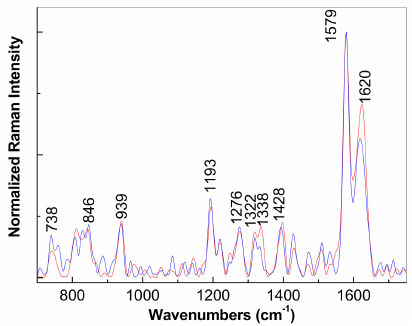
Figure 9. The Raman spectrum of P5A1N electrosynthetized onto the blank Au electrode (blue curve) and the Au electrode covered with the RGO sheets (red